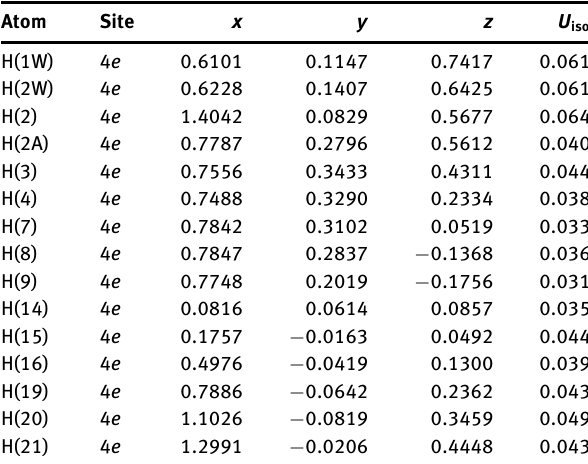
The crystal structure is shown in the figure, Tables 1–3 contain details of the measurement method and a list of the atoms including atomic coordinates and displacement